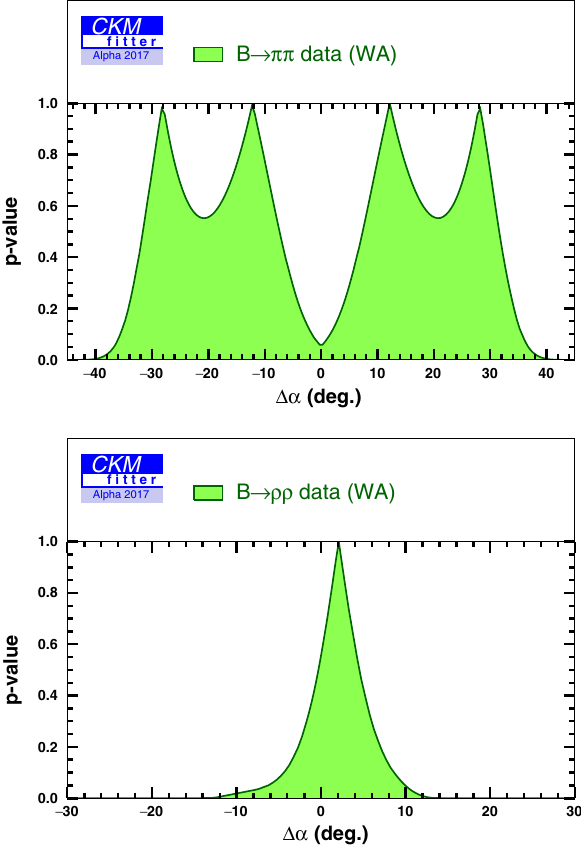
Fig. 22 68% CL constraint on the phase shift Δα = (α − α eff ) for B → ππ ( top ) and B → ρρ ( bottom